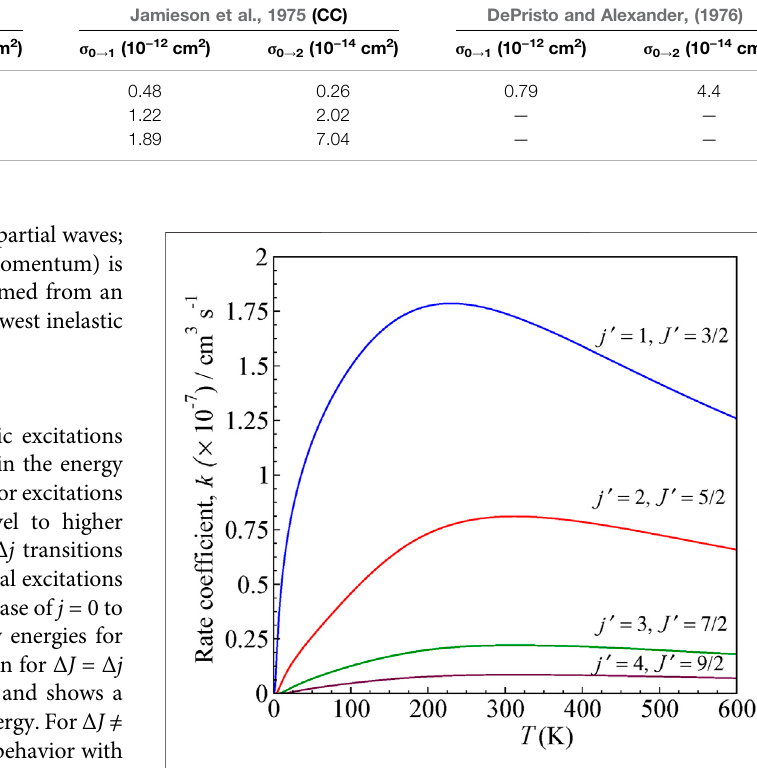
FIGURE 6 | State-to-state rate as a function of temperature for 0 – 600 K computedfor Δ J (cid:1) Δ j transitionsfromtheinitiallevel j (cid:1) 0and J (cid:1) ½forH + + CN ( j (cid:1) 0 , J (cid:1) ½) → H + + CN ( j ’ , J ′ )